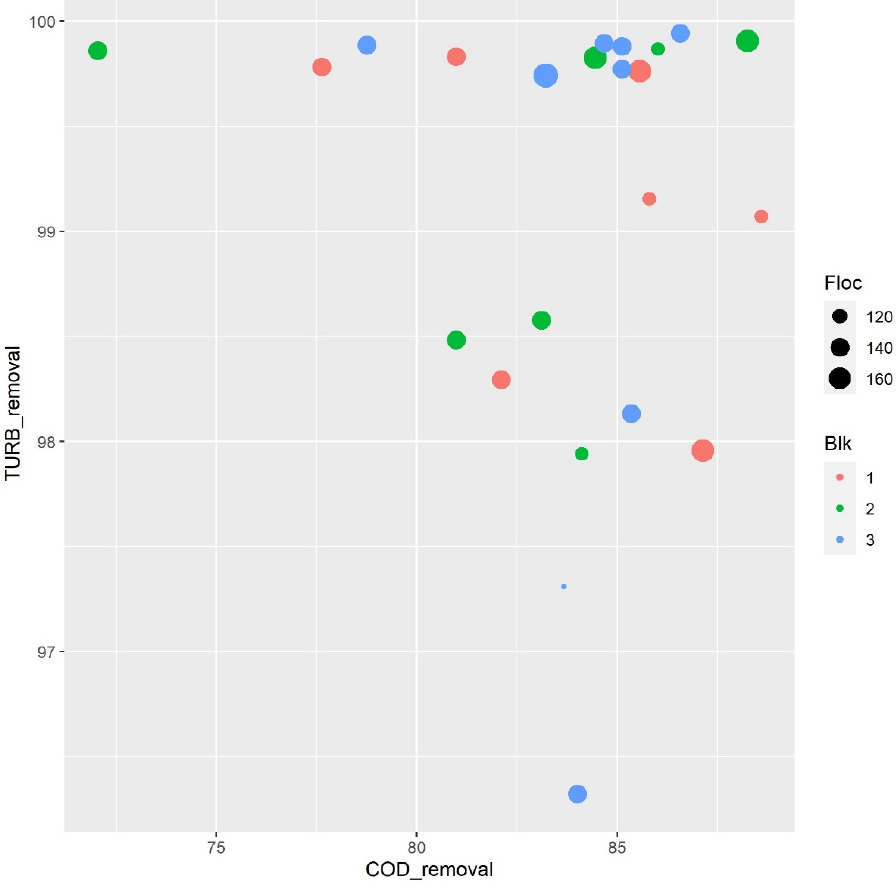
Figure 2. Effect of flocculent concentration on COD and turbidity removal. Floc: Flocculent concentration (120 µL, 140 µL,160 µL);Blk : Blocks number (Blk1,Blk2, Blk3).